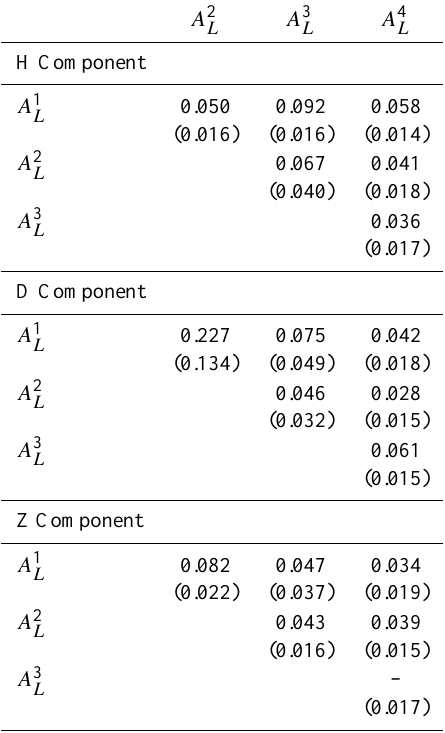
Table 2. The mutual information MI (A i the same NOC decomposition ( L = H,D or Z ). Values in round brackets are the corresponding 5% significance threshold values. The lowercase L stands for H , D and Z magnetic field elements, respectively. Remind that MI (A i tual information a symmetric